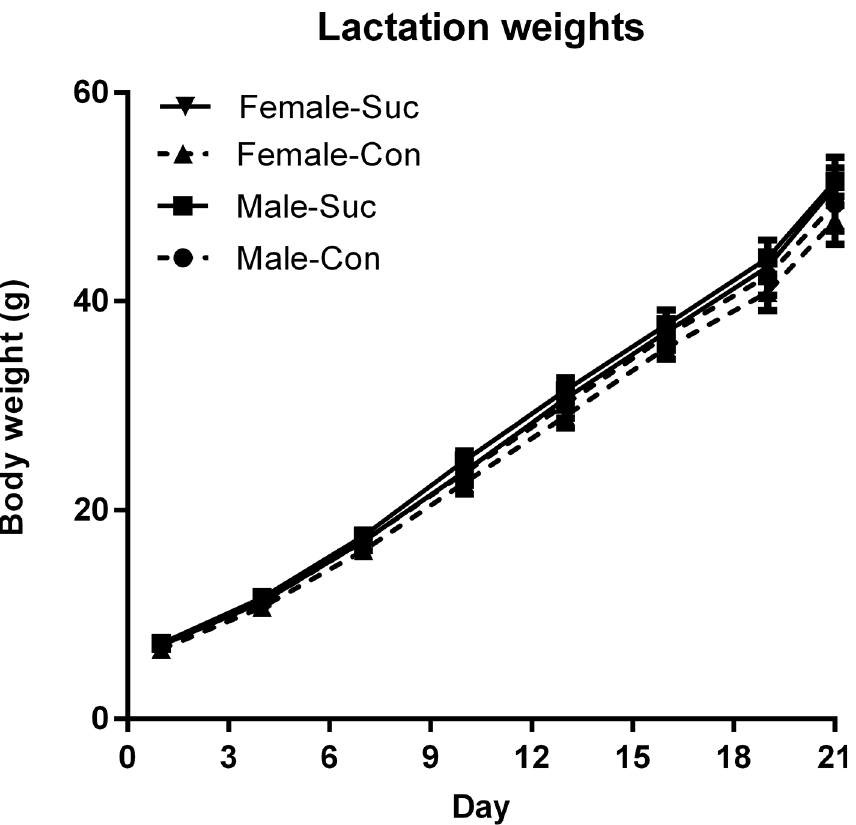
Fig 4. Offspring body weight gain. The rate of weight gain over lactation did not differ between offspring of Sucrose and Control mothers for either males or females.